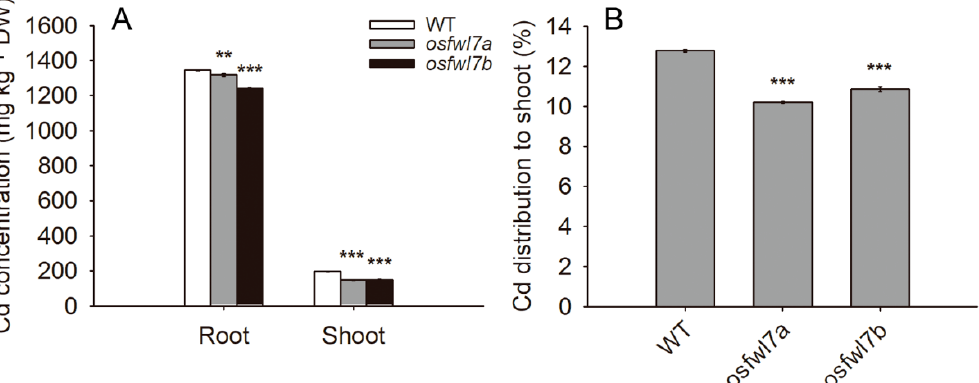
Figure 3. Effect of osfwl7 mutation on Cd accumulation and translocation. ( A ) Measurement of Cd levels in the wildtype (WT) and osfwl7 mutants grown in the presence of 50 μ M Cd for 10 days. ( B ) The percentage of Cd distributed to the shoot. Error bars indicate the standard deviation of three biological replicates. ** p < 0.01, *** p < 0.001.